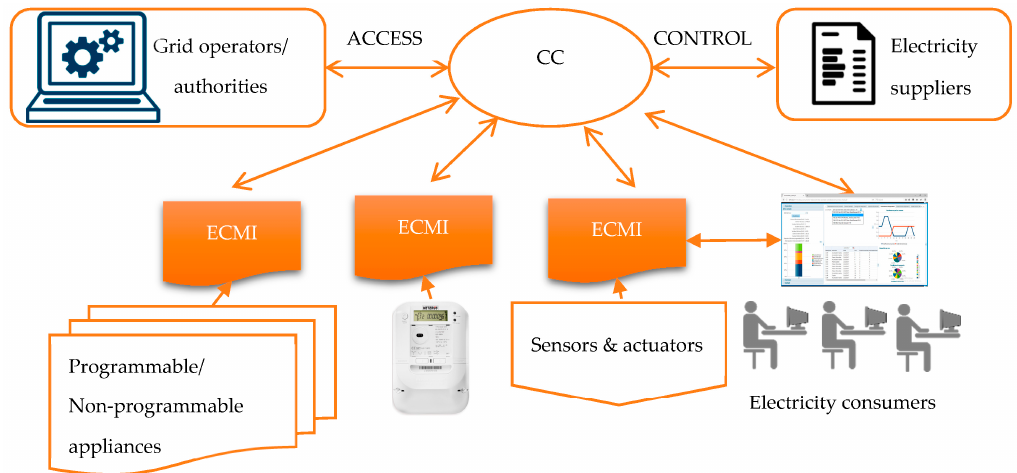
Figure 1. Electricity consumption management components.